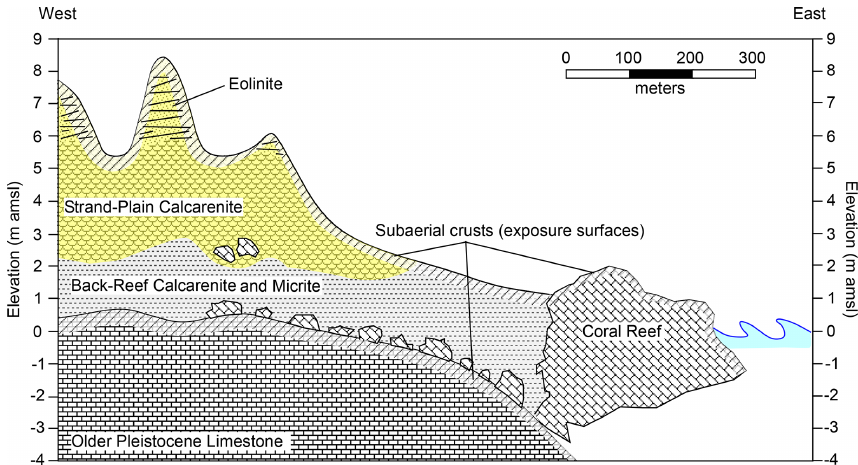
Figure 9. Schematic cross section through the LIG coastline of the Yucatán Peninsula of Mexico (redrawn from Szabo et al., 1978). See Fig. 8 for a general location.